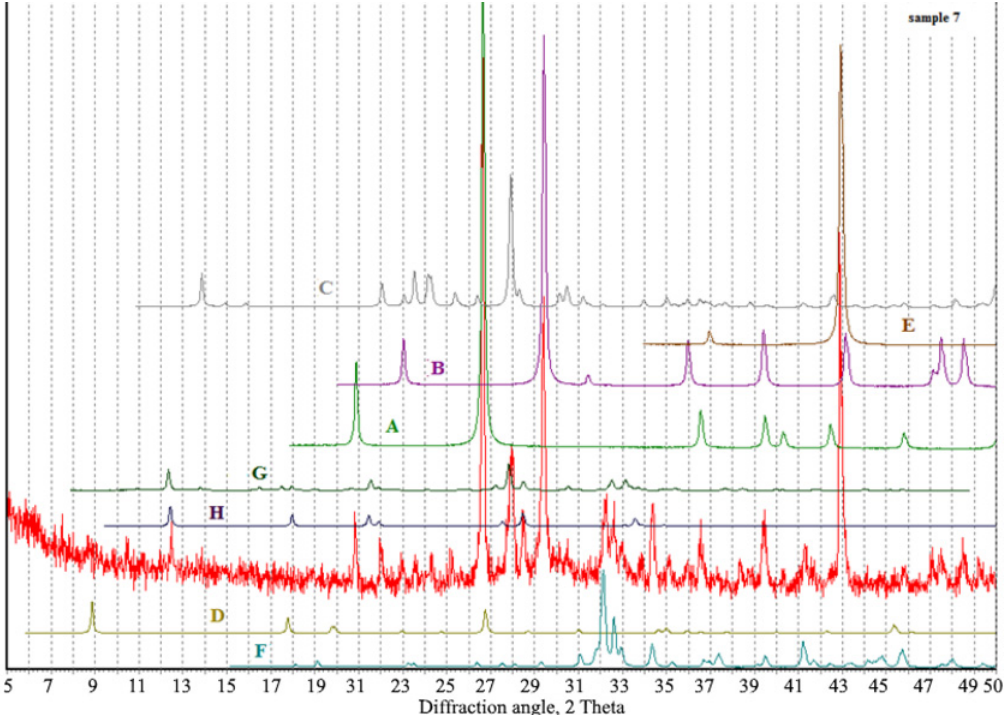
Figure 9. Diffraction pattern of the sample based on the clinker dust from the electrostatic precipitators. The crystal phases for comparison comprise: A—quartz, B—calcite, C—albite, D—muscovite,